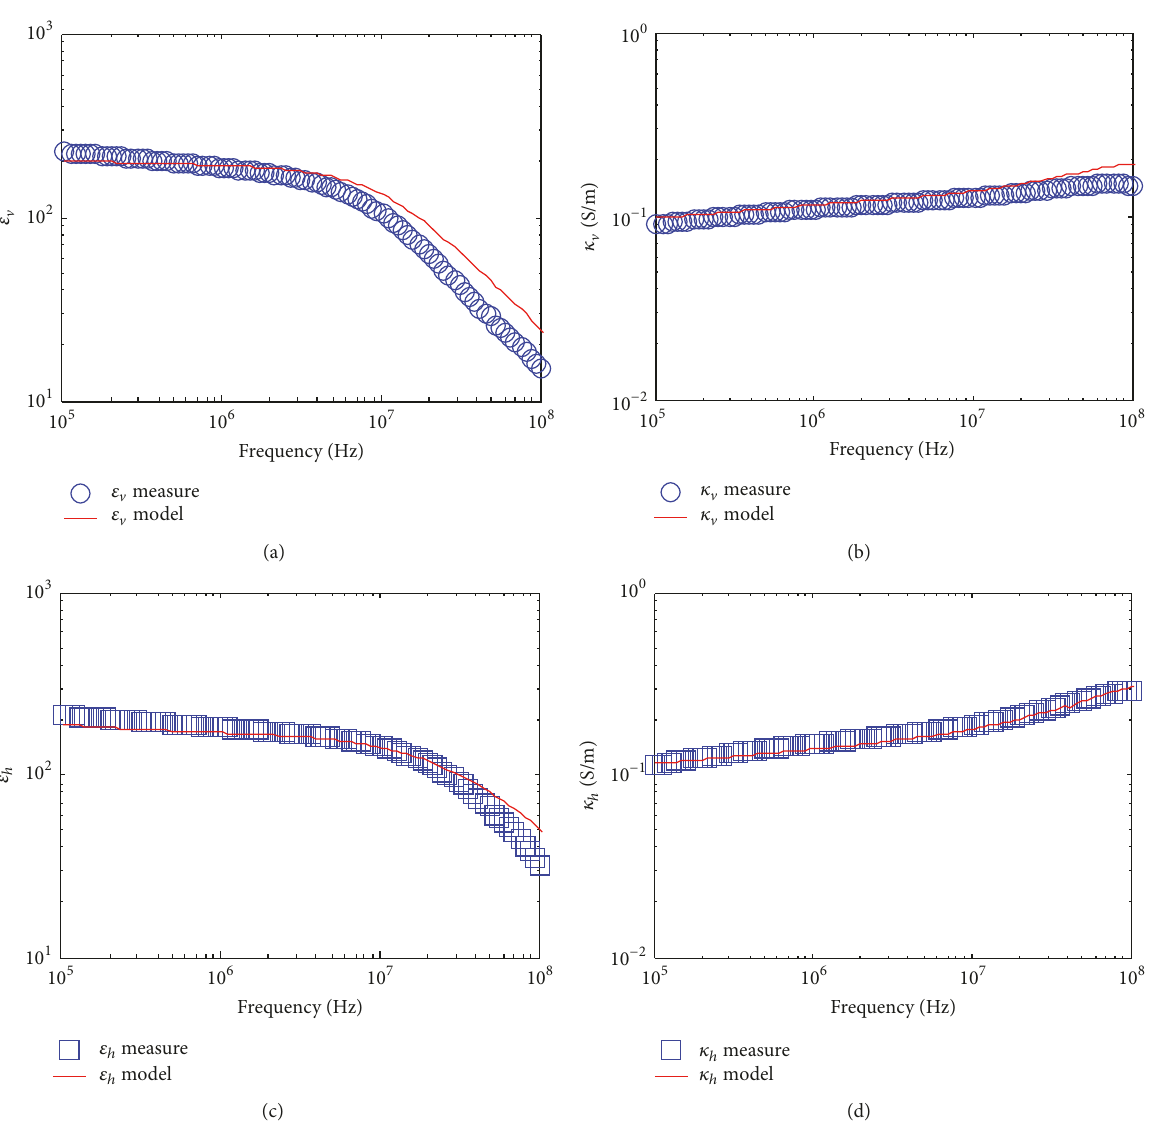
Figure 6: Comparison of the experimental measurements with the modeling results for the artificial shale sample A2575 75. The correlation coefficients are R = 0.9833 and R = 0.9775, respectively, for the relative permittivity and conductivity in the vertical direction and R = 0.9979 and R = 0.9940 for the relative permittivity and conductivity in the horizontal direction,